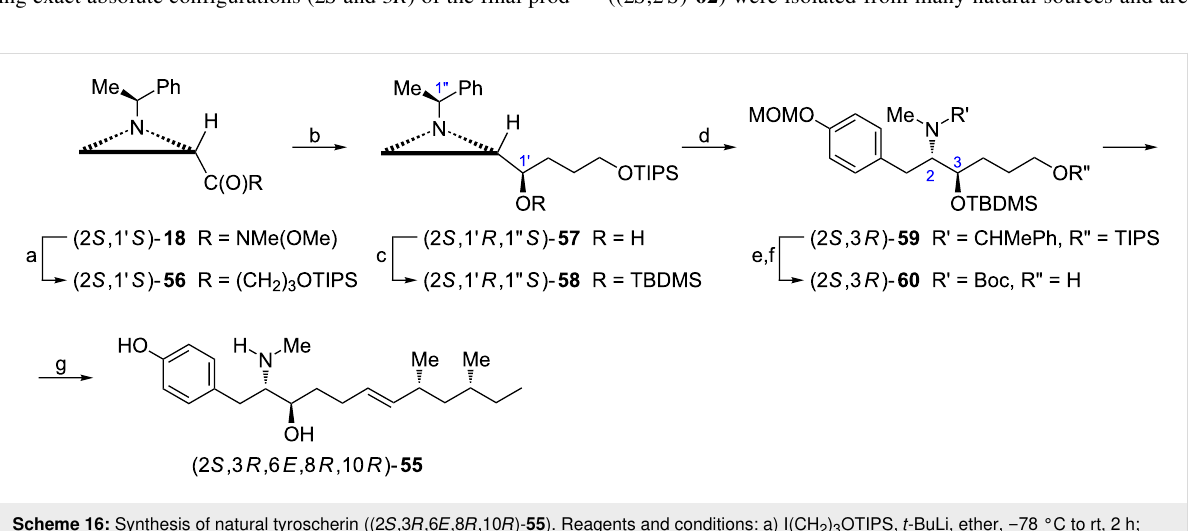
tion of (1 S ,2 S )- 49 and provided a basis for the inversion of con- figuration at C2 by O -mesylation and intramolecular displace- ment to yield the 2-oxazoline (4 S ,5 R )- 54 readily hydrolyzed to florfenicol ((1 R ,2 S )- 49